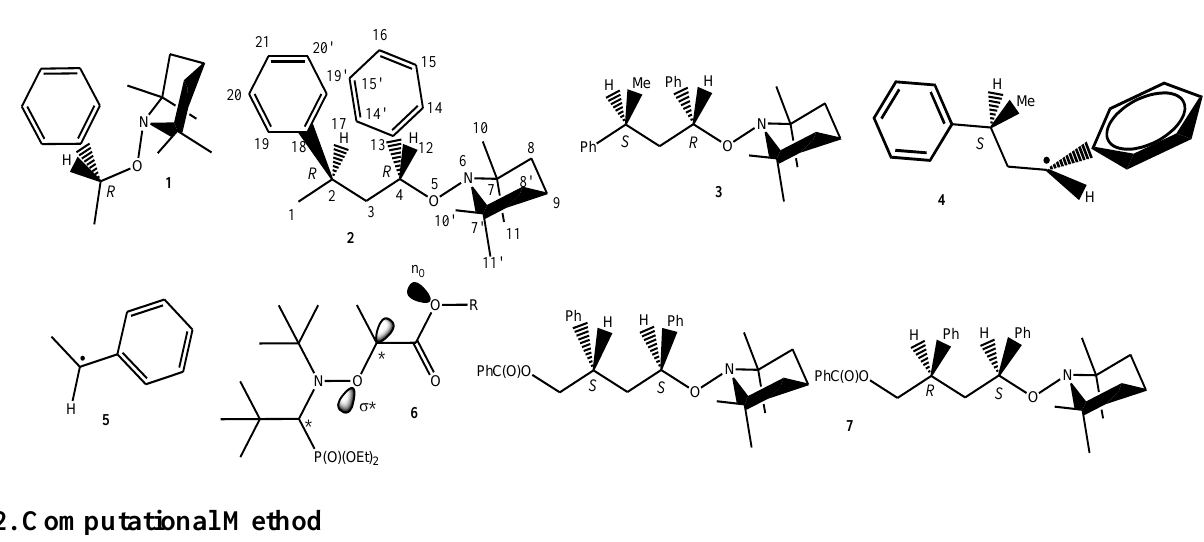
Figure 1. Molecules